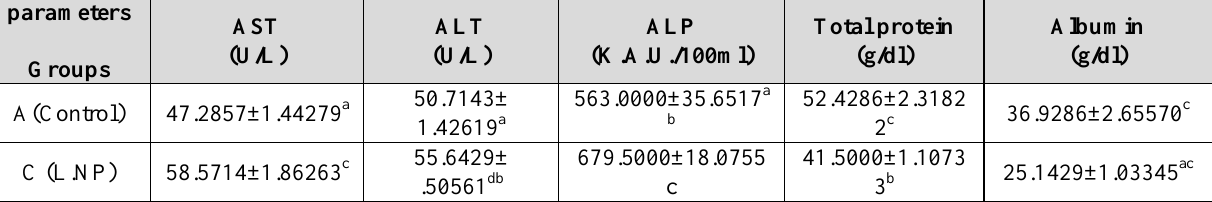
Table 2: Effect of PbNPs on the enzymes and proteins.